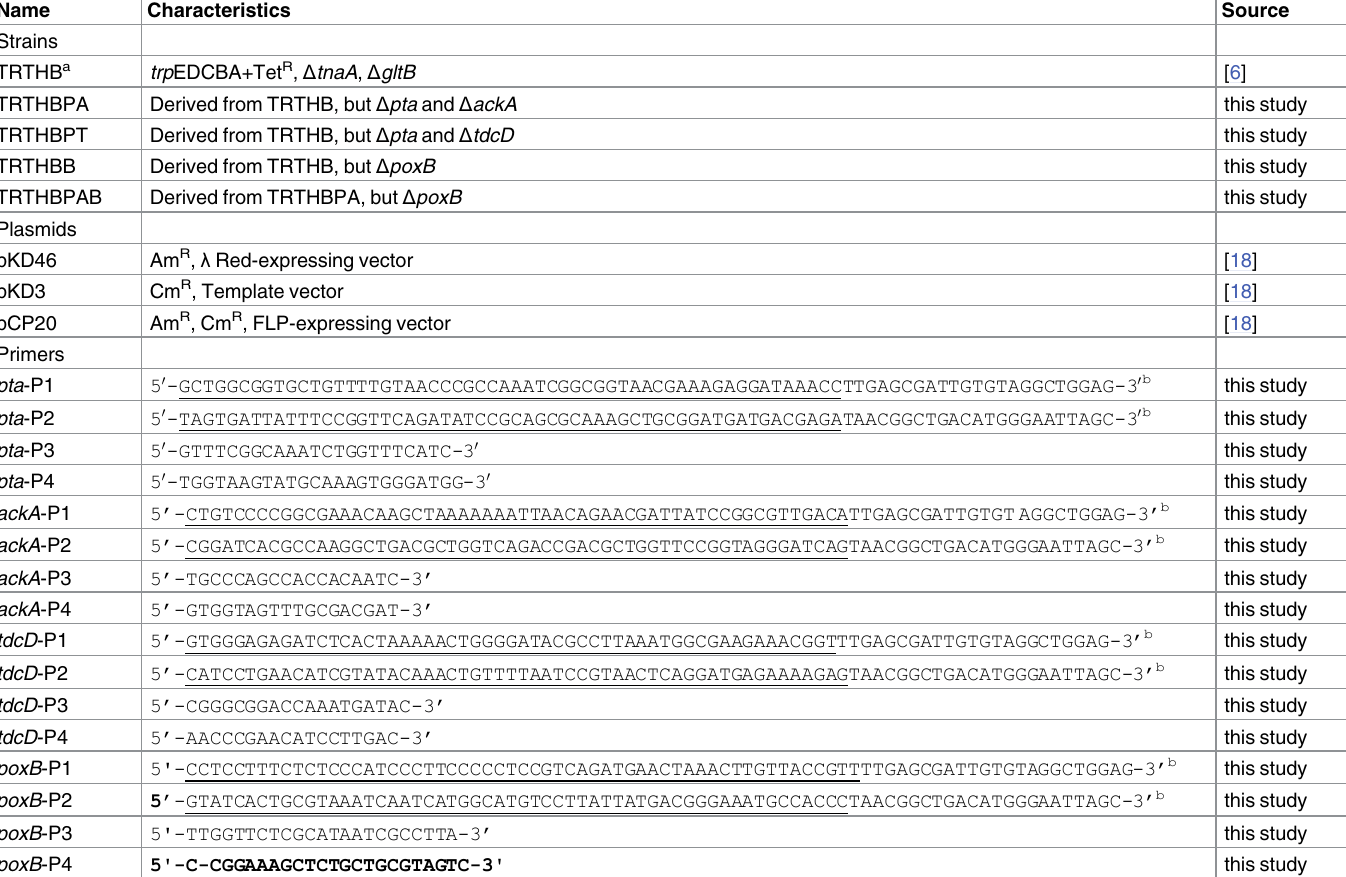
Table 1. Strains, plasmids, and primers used in this